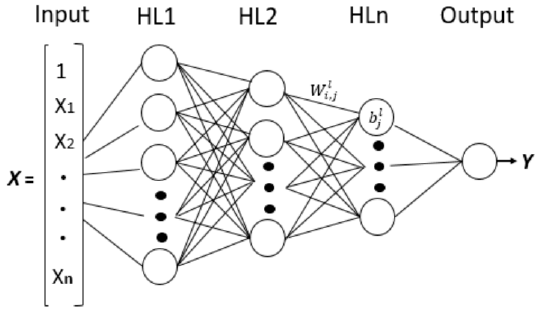
Figure 1. A scheme of fully connected “Deep” neural network.